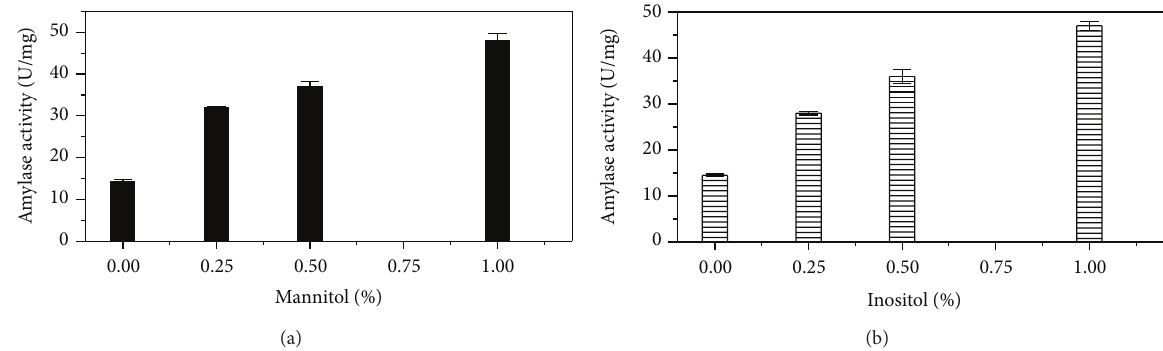
Figure 6: Effect of sugar alcohol (D-mannitol and D-inositol) on amylase production after 48 hours of SSF; lined column: specific activity of 𝛼 -amylase in presence of inositol from SSF extract; black column: specific activity of 𝛼 -amylase in presence of mannitol from SSF extract.